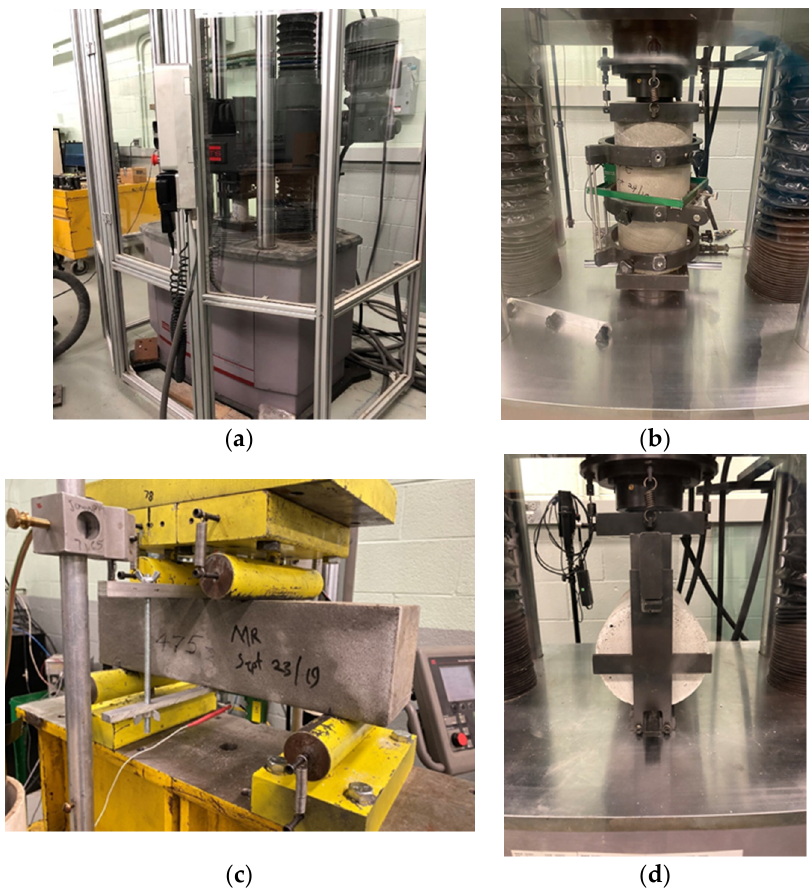
Figure 2. Experimental test set-ups of LCC. ( a ) Compressive strength test. ( b ) Modulus of elasticity test. ( c ) Modulus of rupture test. ( d ) Splitting tensile test.